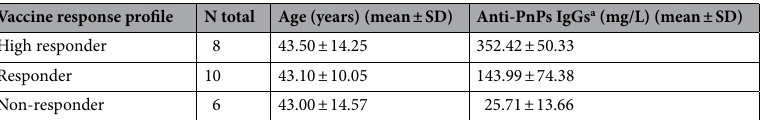
Table 1. No significant age differences were observed among groups (ANOVA test p value = 0.99).